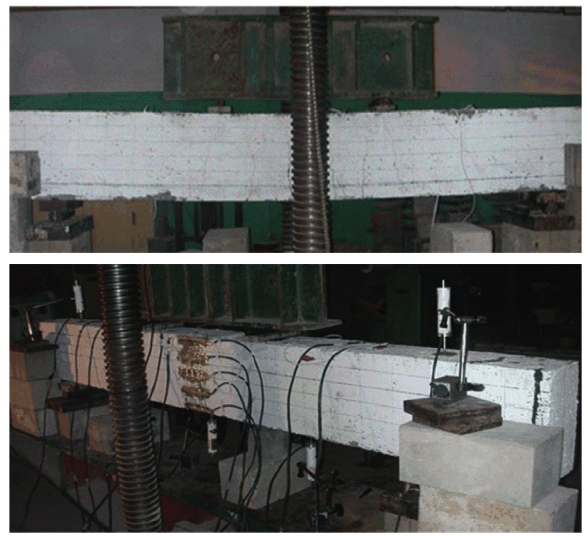
Figure 5: Test setup.